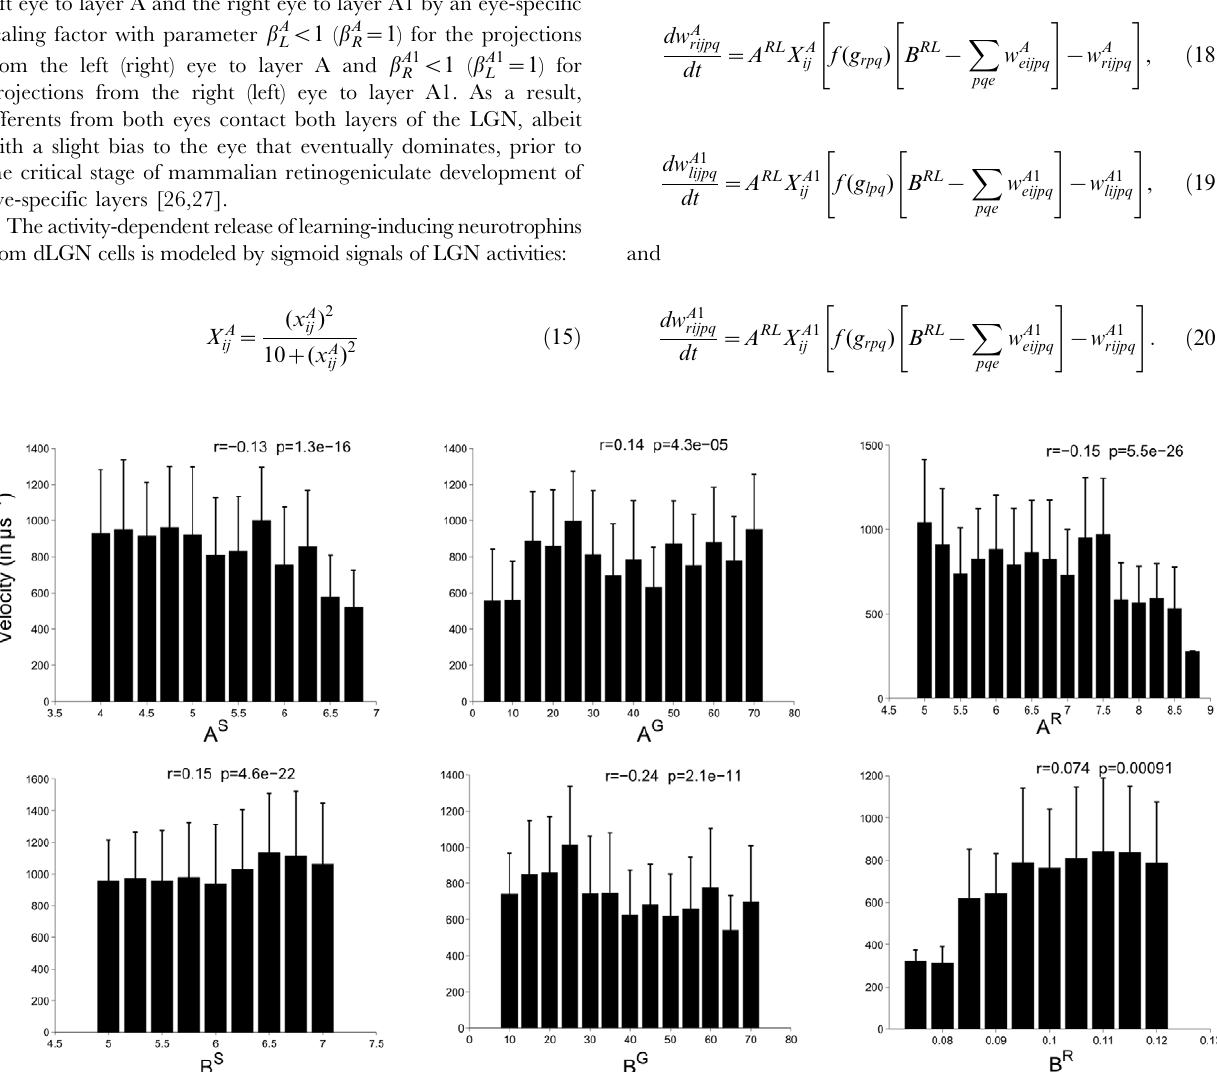
Figure 7. The effect of changing model parameters A S B S A G B G B R A R on wave velocity. The effects on velocity are weak, but statistically significant. As with WPM, increasing A R and A S decreases velocity, and vice versa for B R and B S . Unlike the periodicity of waves, their velocity is significantly modulated by the properties of the model RGCs via A G and B G .